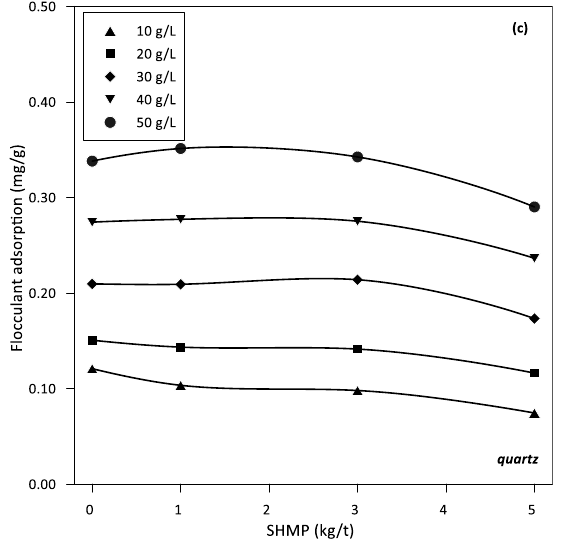
Figure 4. Flocculant adsorption versus SHMP concentration for muscovite ( a ), kaolinite ( b ), and quartz ( c ). pH 9 in seawater. Flocculant dose in g/L.